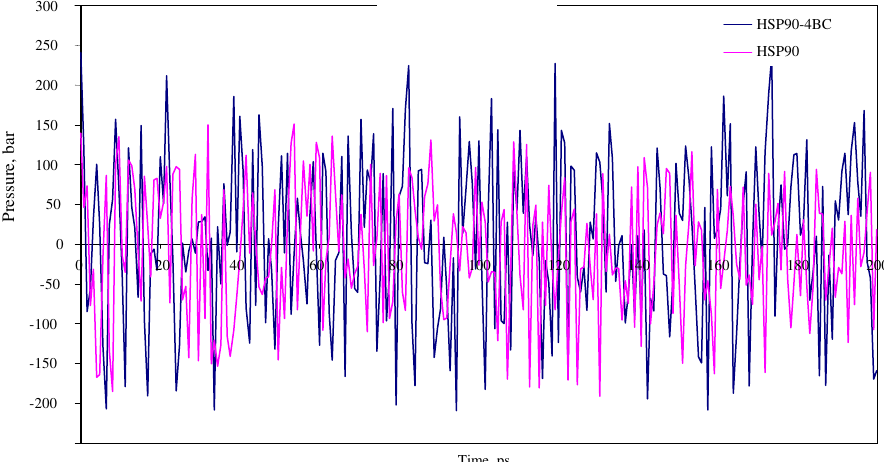
Figure 6. Time evolution of pressure for simulated Hsp90-4BC box